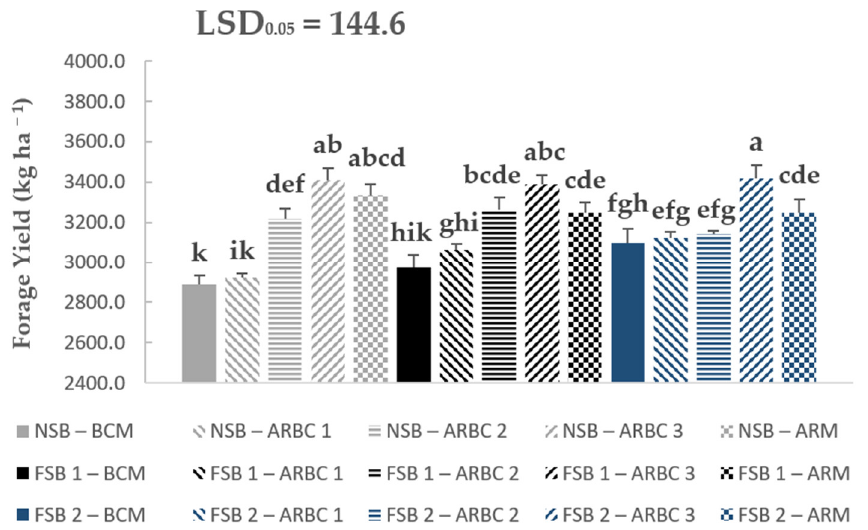
Figure 7. Forage yield (kg ha −1 ) in the second harvest. Data were pooled over 2020–2021 and 2021– 2022. Data refer to the interaction between seedbed (S) and forage (F) factors. NSB: Normal seedbed,